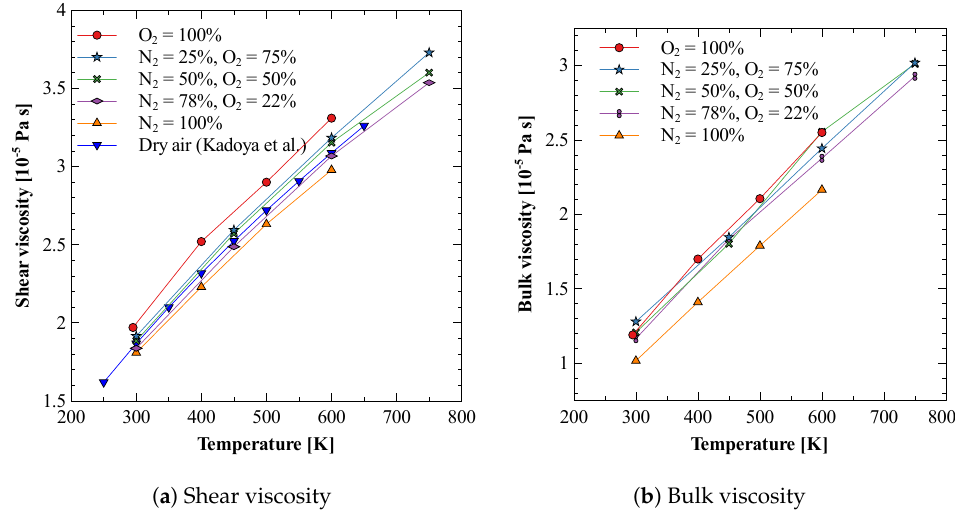
Figure 4. Bulk and shear viscosity of N 2 and O 2 mixture at various compositions [78].